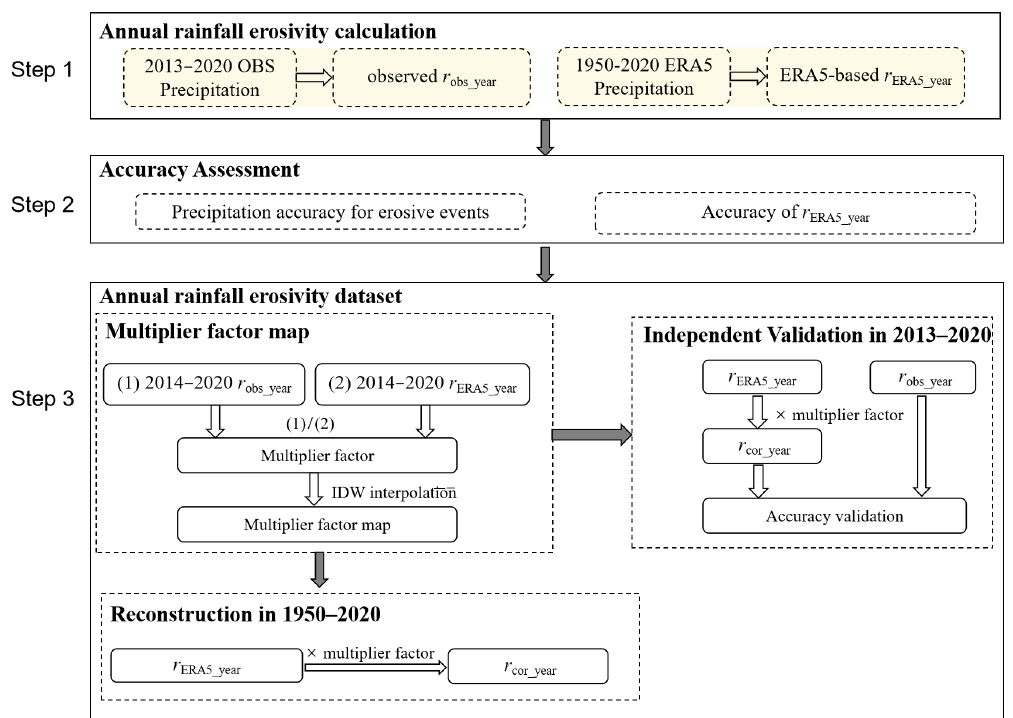
Figure 2. Schematic representation of algorithm for generating annual rainfall erosivity dataset for 1950–2020. r obs_year and r ERA5_year rep- resent the station-based and ERA5-based annual rainfall erosivity values, respectively. r cor_year means the corrected values of the r ERA5_year by using the multiplier factor map.